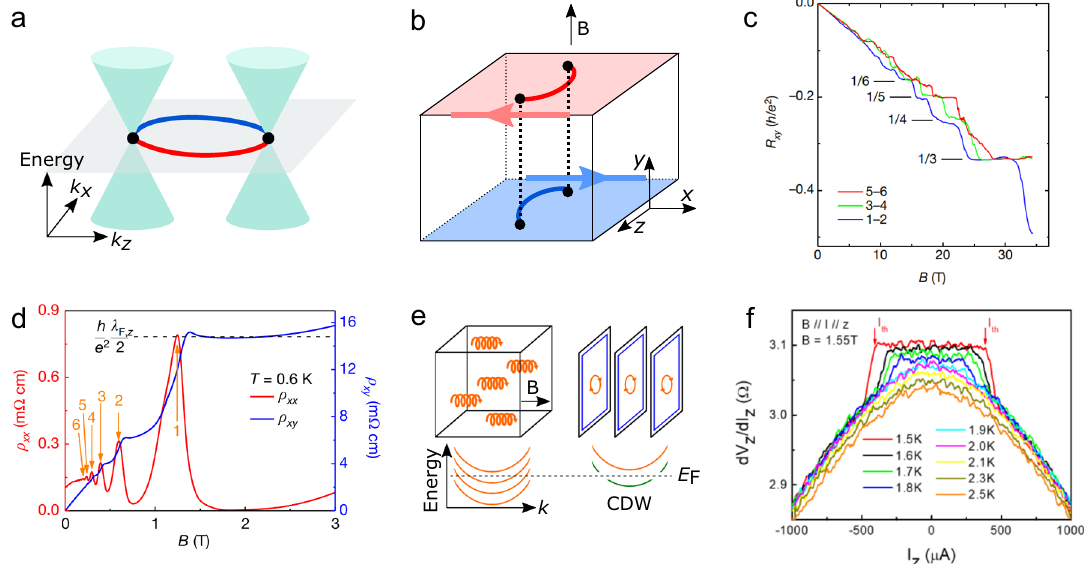
Fig. 1 3D quantum Hall effect. a The energy dispersion of the 3D bulk states (green) of a Weyl semimetal, and the Fermi arcs (the Fermi surface of the topologically protected surface states, red for the top surface and blue for the bottom surface). The black spots denote the Weyl nodes. b Schematic of the Fermi-arc mechanism of the 3D quantum Hall effect in Weyl semimetals. The red and blue arrows depict the hinge states. c The Hall resistance measured at three pairs of Hall electrodes (of different cross-sectional thicknesses) in a wedge-shaped Cd 3 As 2 sample. Adapted from Ref. 37 . d The Hall ( ρ xy ) and longitudinal ( ρ xx ) resistivities measured for the charge-density-wave mechanism of the 3D quantum Hall effect in ZrTe 5 . e Left: Fermi energy crossing the Landau bands in 3D materials; right: bulk gap in Landau bands induced by charge-density wave (CDW). f Non-Ohmic I-V characteristic in ZrTe 5 . d and f are adapted from Ref. 38